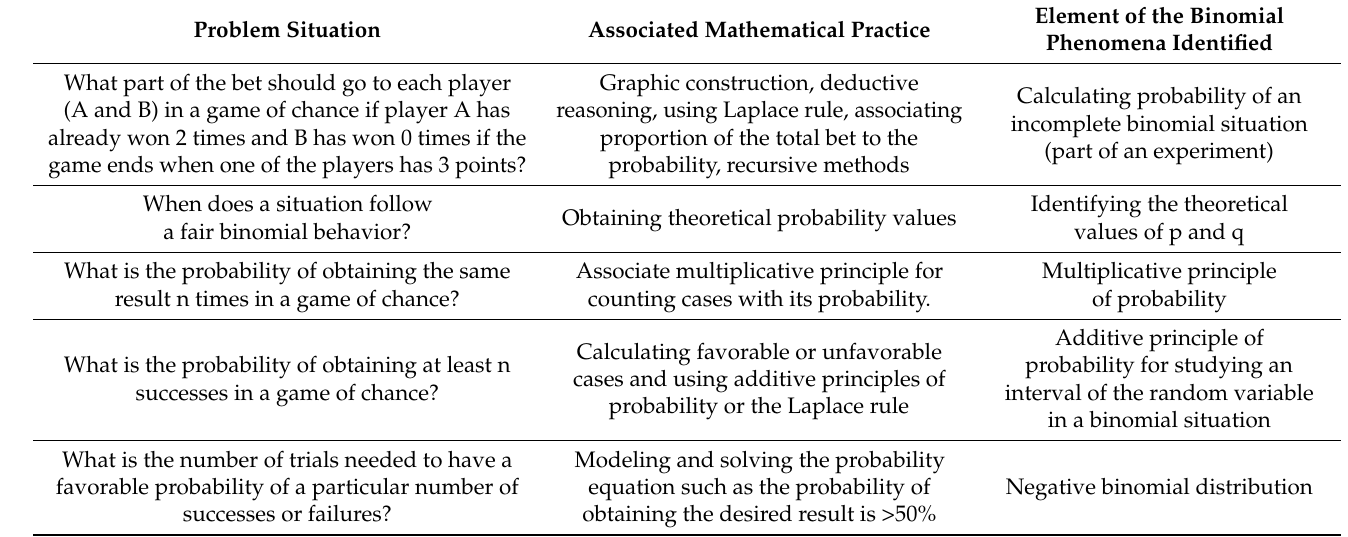
Table 6. How problem situations from historical problem situations (15th century–17th century) could be proposed in the current curricula.